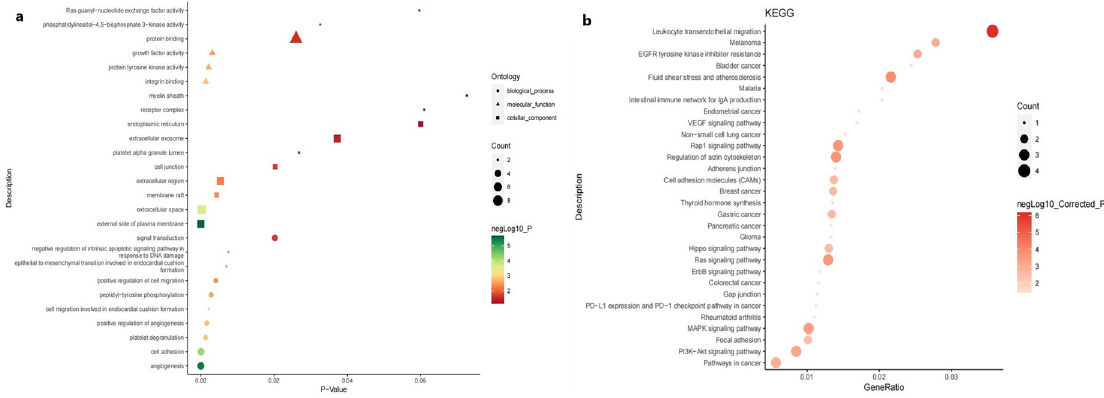
Fig 3. GO enrichment analysis (a) and KEGG analysis (b) of the genes in the most significant module in